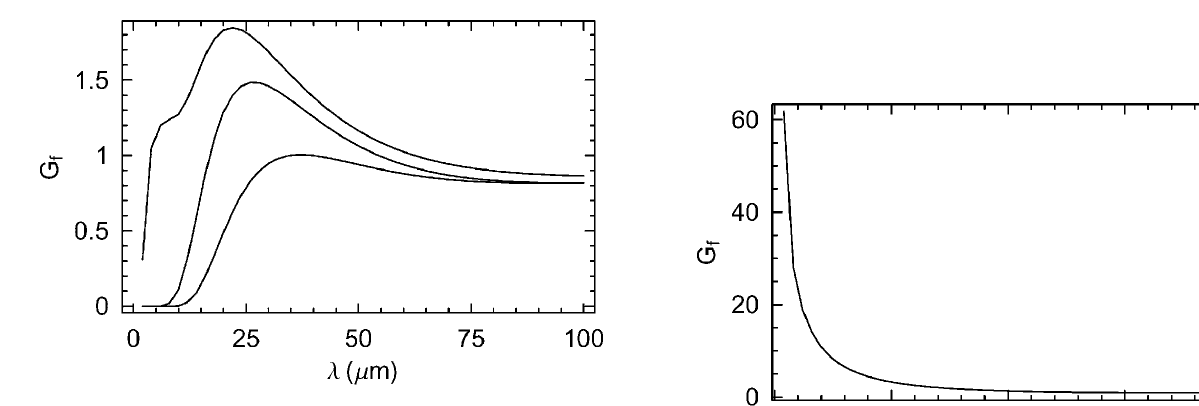
as a function of wave- f (cid:1) 3 : 0 (cid:4) p (cid:1) 3 : 0 (cid:4) 10 (cid:3) 5 , (cid:9) (cid:1) 0 ; (3) (cid:7) (cid:1) 3 : 0 (cid:4) FIG. 2. Amplification factor G p p for the zero beam emittance and (cid:7)